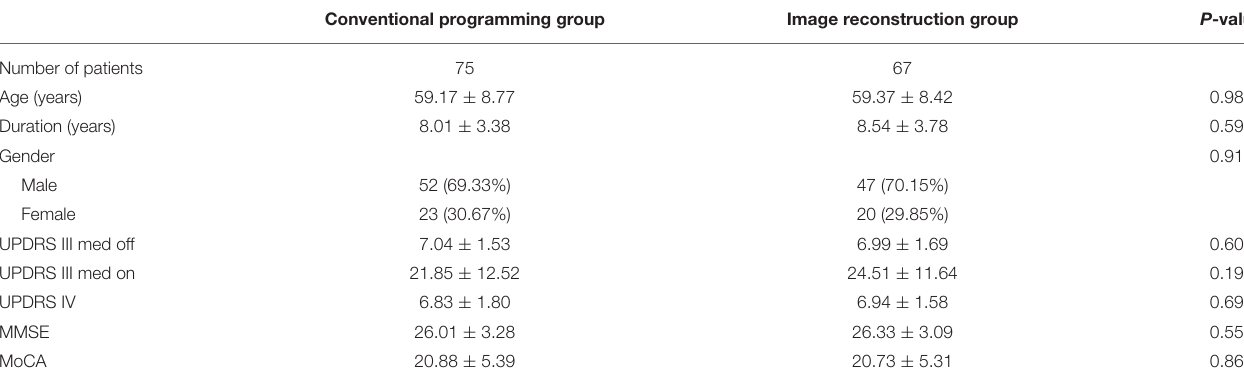
TABLE 1 | Characteristics of the patients with image reconstruction group and conventional programming